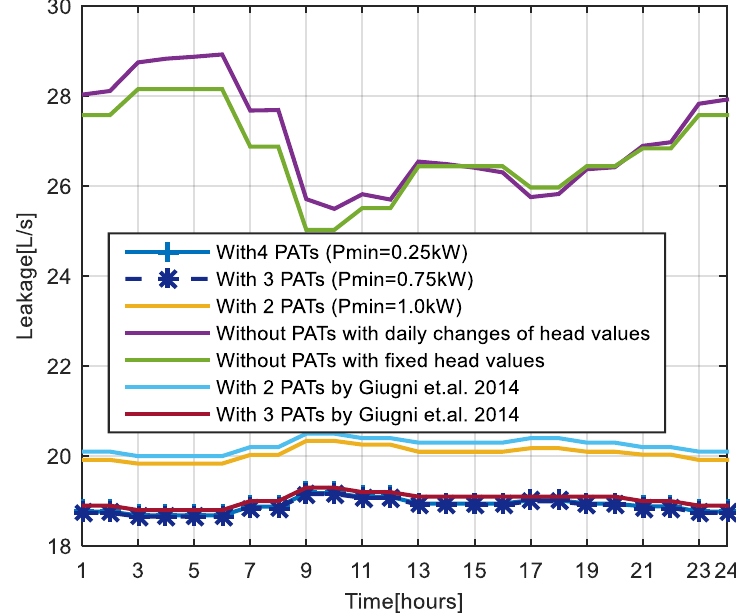
Figure 8. Comparison of water leakage flows during 24 h in the three scenarios.